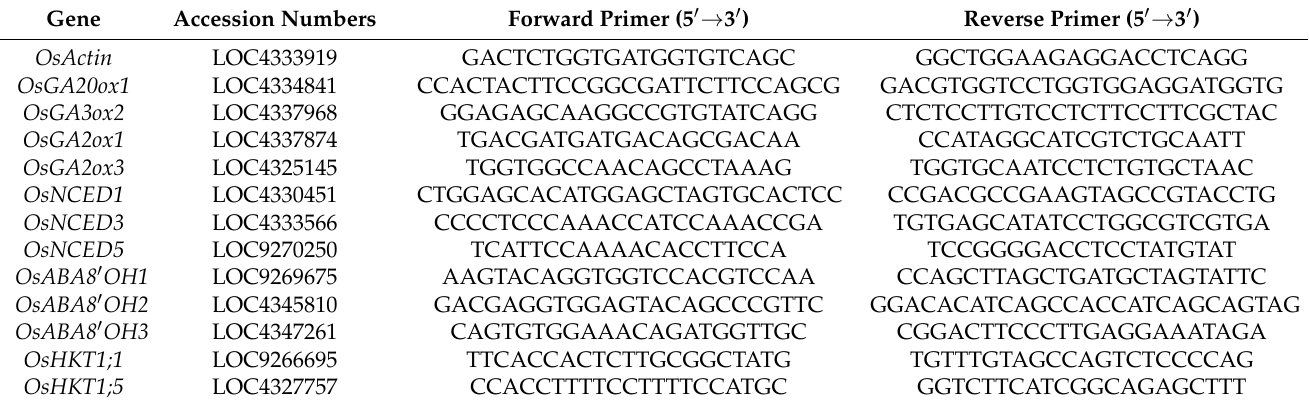
Table 1. Primers used for quantitative real-time PCR in this